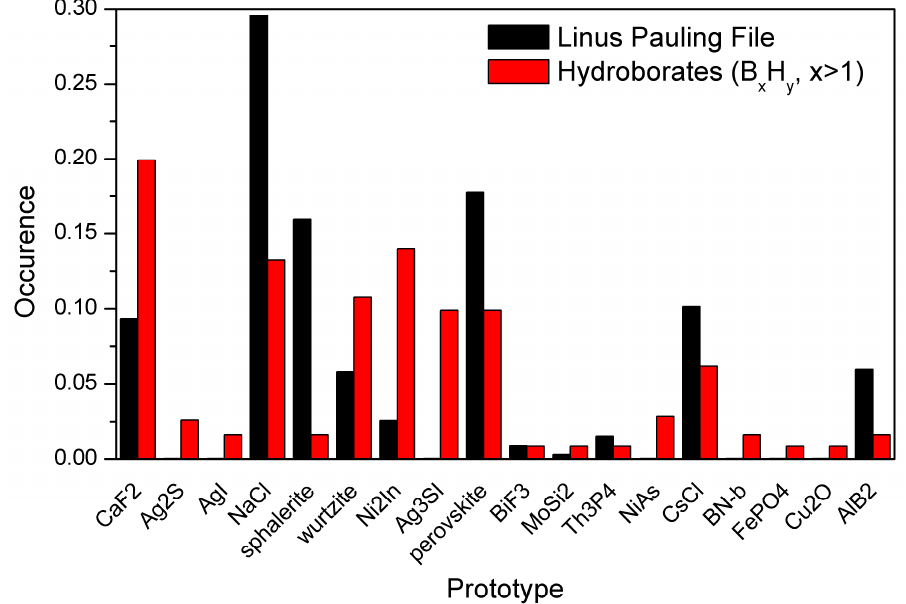
Figure 4. Occurrence of selected structural prototypes among binary inorganic compounds extracted from the Linus Pauling File [51], and among the hydroborates (excluding borohydrides with BH 4 − anion). Both graphs include ternary solid solutions. The fractions are renormalized, to sum up to one for each graph.